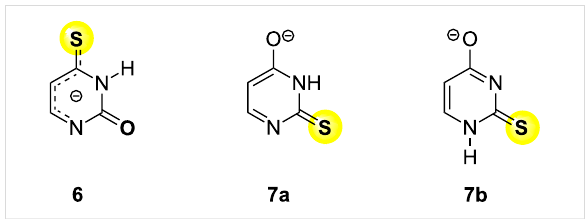
Figure 3: Supposed monoanionic forms of 4-thiouracil and 2-thiouracil in aqueous medium